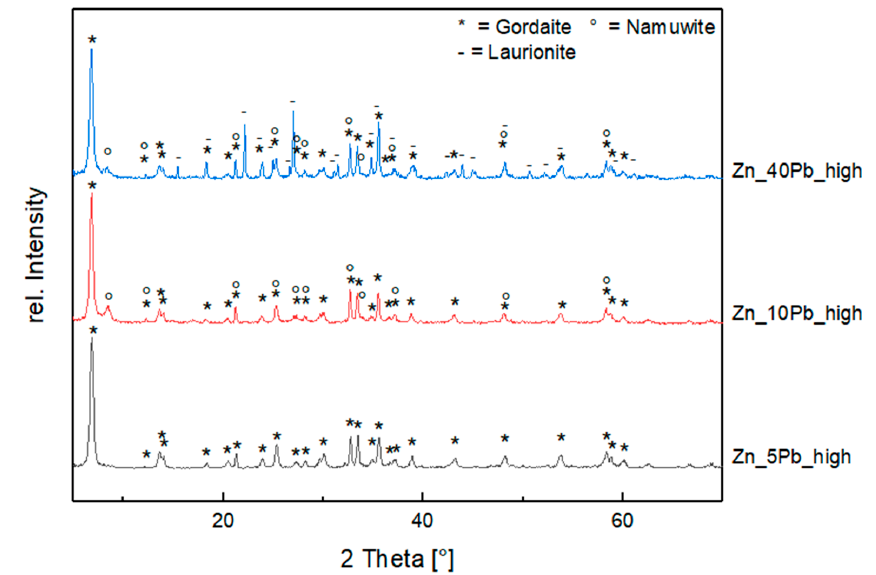
Figure 5. XRD pattern (Cu K α 1 ) of the washed precipitates in the Zn–Pb–salt system (exp. set 3) with increasing Pb content in high saline solution.